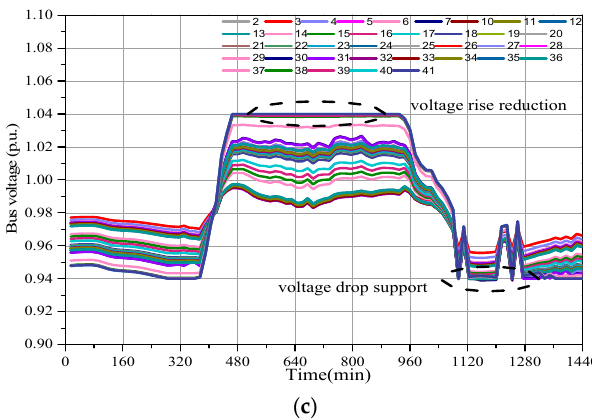
Figure 6. Curves of node voltages: ( a ) Node voltages in the case without batteries; ( b ) Node voltages in Case 1; ( c ) Node voltages in Case 2.